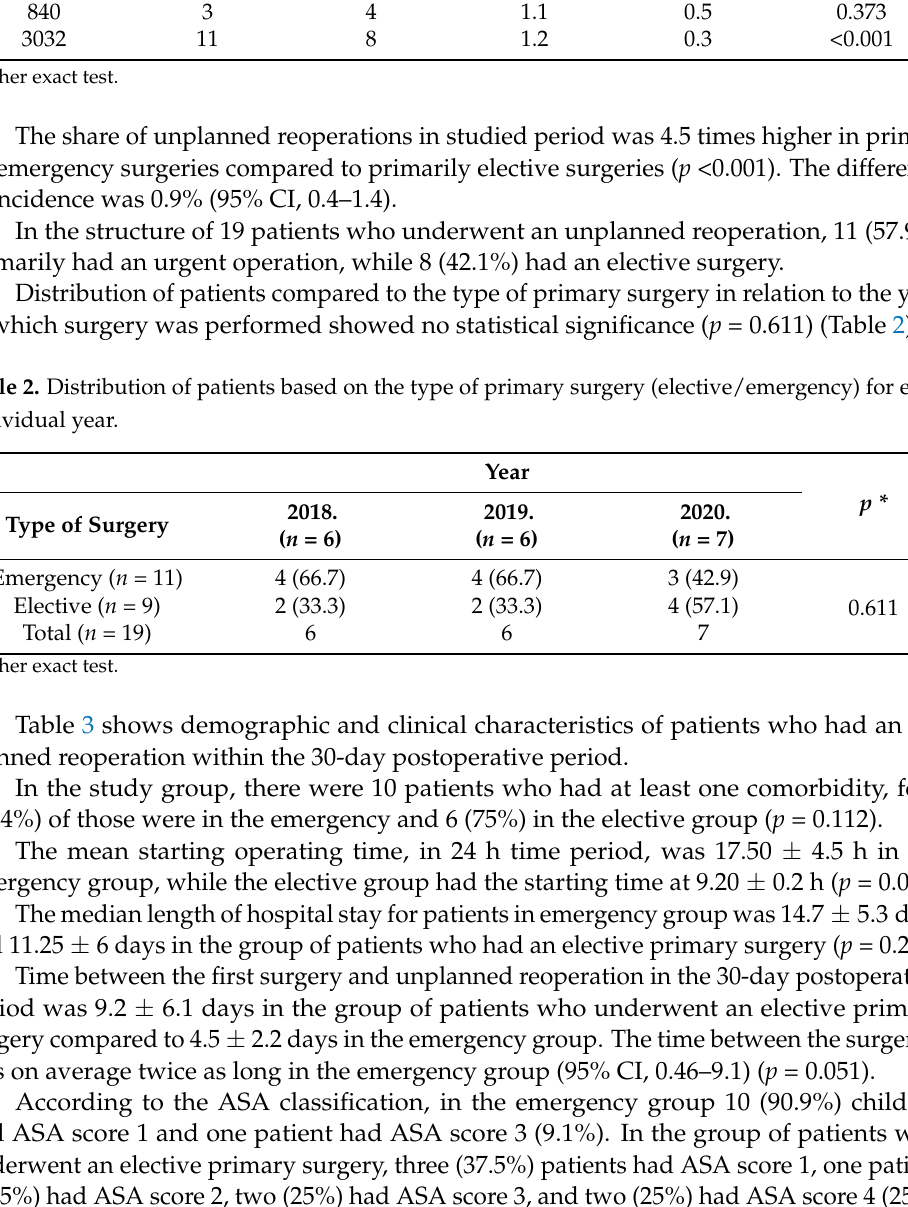
Table 1. Relation between number of emergency/elective surgeries in relation to the number of unplanned reoperations in the 30-day postoperative period and their share in the total number of surgeries performed in each individual year.